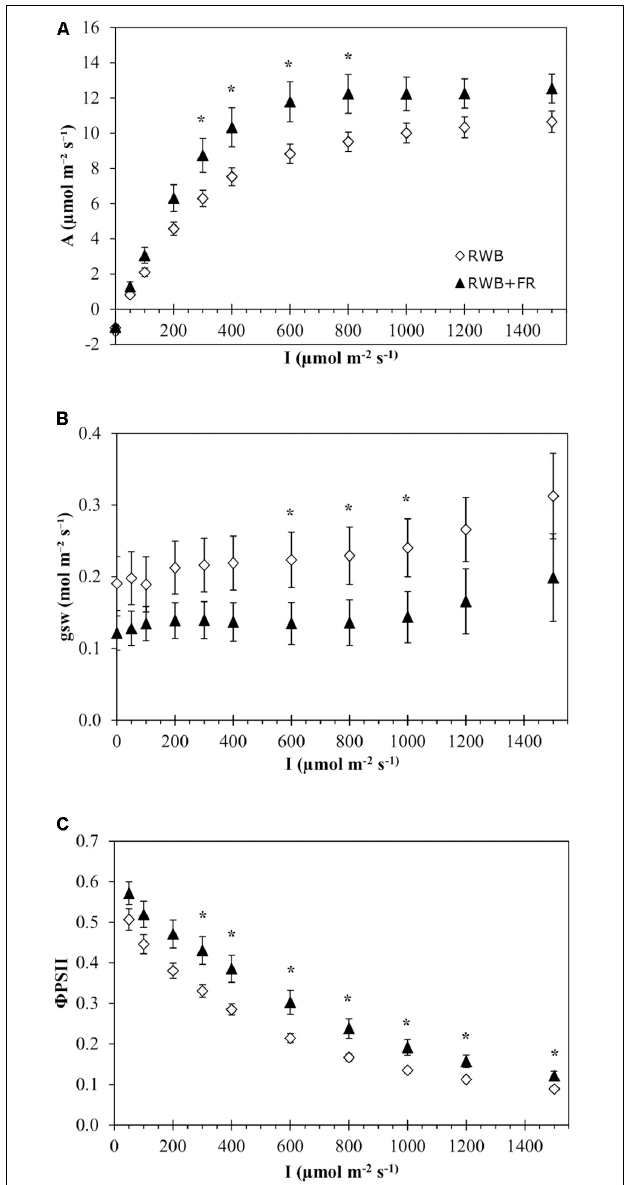
FIGURE 2 | Effect of the light treatments RWB and RWB + FR on the pattern of (A) net photosynthetic response, (B) stomatal conductance, and (C) (cid:56) PSII to a series of light intensities (0–1,500 µ mol m - 2 s - 1 ) of the uppermost unshaded leaves of Solanum melongena , variety Tracey. Each data point represents the mean of two series of measurements on four individual plants per treatment ( n = 2; 8 plants per treatment) ± standard error of the mean. Data were analyzed with a one-way ANOVA for all light month of observation (two levels) as block factor. Significant differences ( P ≤ 0.05) between treatments are indicated with asterisk